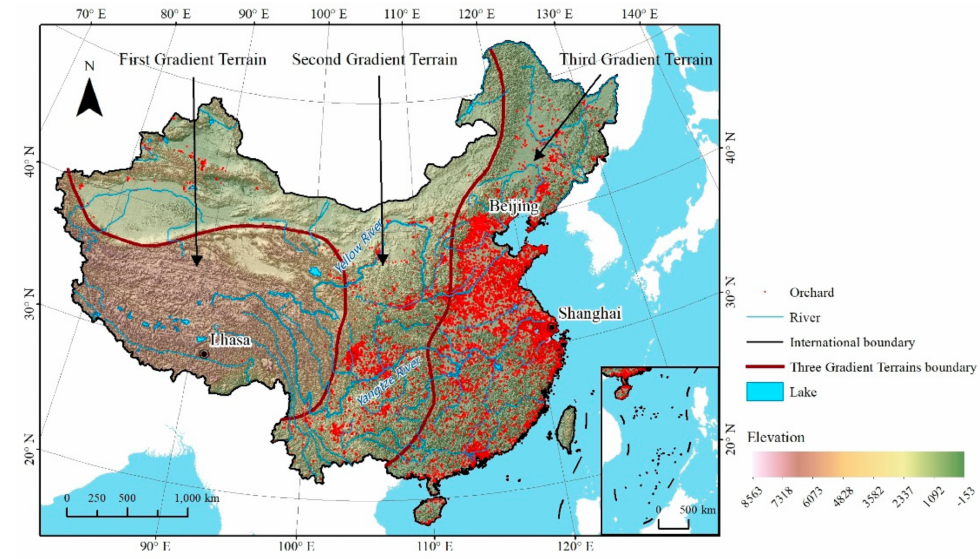
Figure 5. Spatial distribution of picking orchards displayed by comparing the topography in different parts of